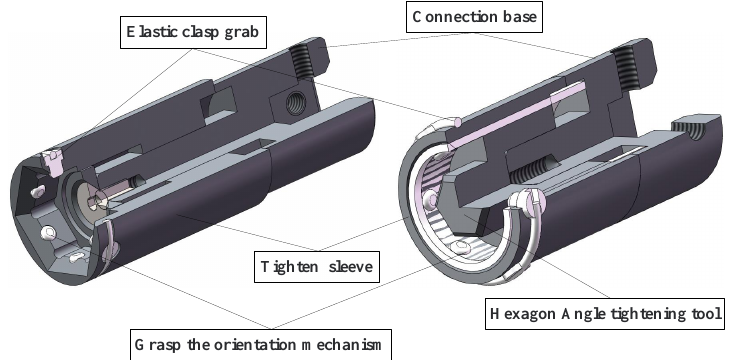
Figure 4. Adaptive bolt tightening